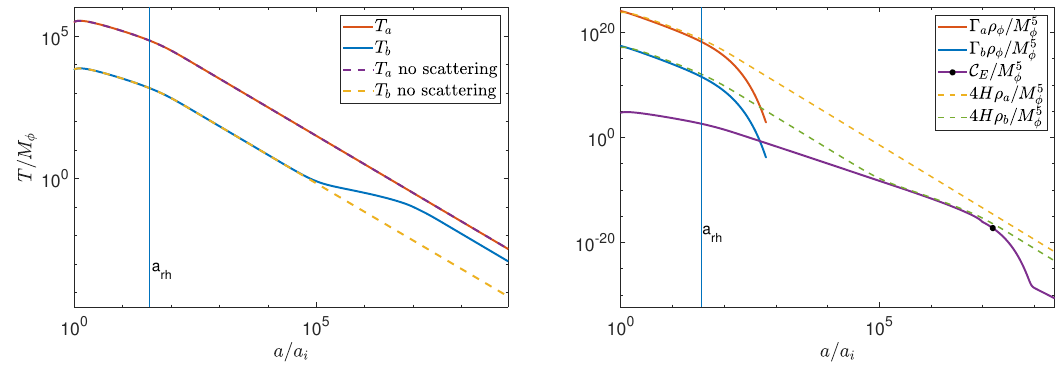
Figure 6. Left panel: example temperature evolution of radiation sectors during and after reheat- ing via scalar trilinear couplings. The solid (dashed) lines denote the temperatures obtained from numerically solving the Boltzmann equations including (neglecting) the in(cid:13)aton-mediated scatter- ings between the sectors. Reheating is denoted by the vertical blue line at a rh . The (cid:12)gure has been plotted for (cid:22) a = 10 (cid:0) 3 M (cid:30) , (cid:22) b = 10 (cid:0) 5 : 5 M (cid:30) , m a;b = 10 (cid:0) 3 M (cid:30) with other parameters as speci(cid:12)ed in eq. (3.3). Right panel: comparison of the collision term to the redshifting of both sectors as well as in(cid:13)aton decays for the same parameters as that in left panel. The black dot on the curve for the collision term indicates T a = M (cid:30) = 4, which approximately indicates the temperature below which the s -channel energy transfer rate becomes exponentially